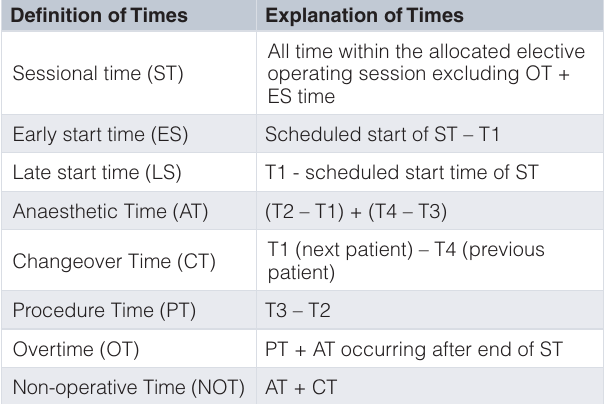
Table 4. Definitions of times extrapolated from the ORMIS data recorded during the audit period. Definition of Times